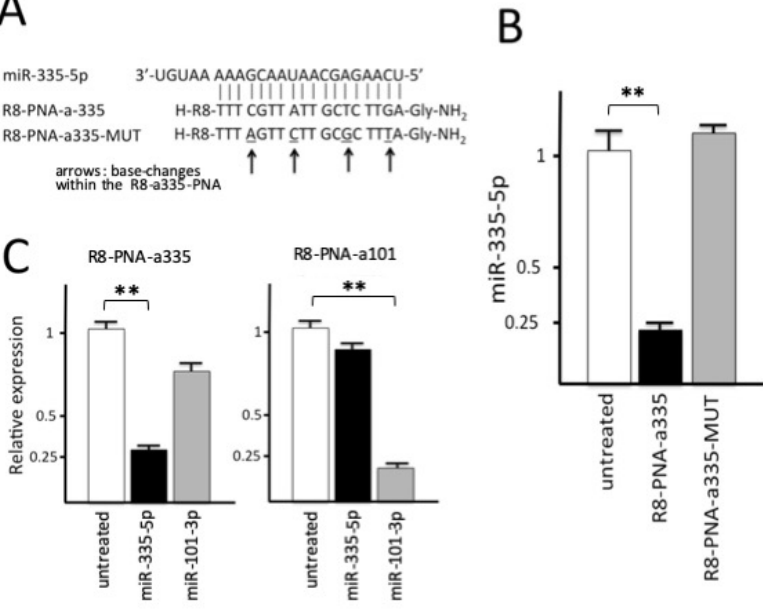
Figure 3. ( A ) Sequences of the R8-PNA-a335 and of the mutated R8-PNA-a335-MUT. The mutations in the R8-PNA-a335-MUT are underlined and arrowed. ( B ) Inhibition of miR-335-5p hybridization signals in Calu-3 cells treated for 72 h with R8-PNA-a335 (black box) and mutated R8-PNA-a335-MUT (gray box) molecules (4 µ M); white boxes: untreated Calu-3 cells. ( C ) Effects of treatments of Calu-3 cells with R8-PNA-a335 and R8-PNA-a101 on miR-335-5p (black boxes) and miR-101-3p (gray boxes) hybridization signals. Treatments were carried out for 72 h with 4 µ M R8-PNA-a335 and R8-PNA-a101. Results are expressed as mean ± standard error of the mean (SEM) of at least three independent experiments. ** Statistical significance at p<0.01.